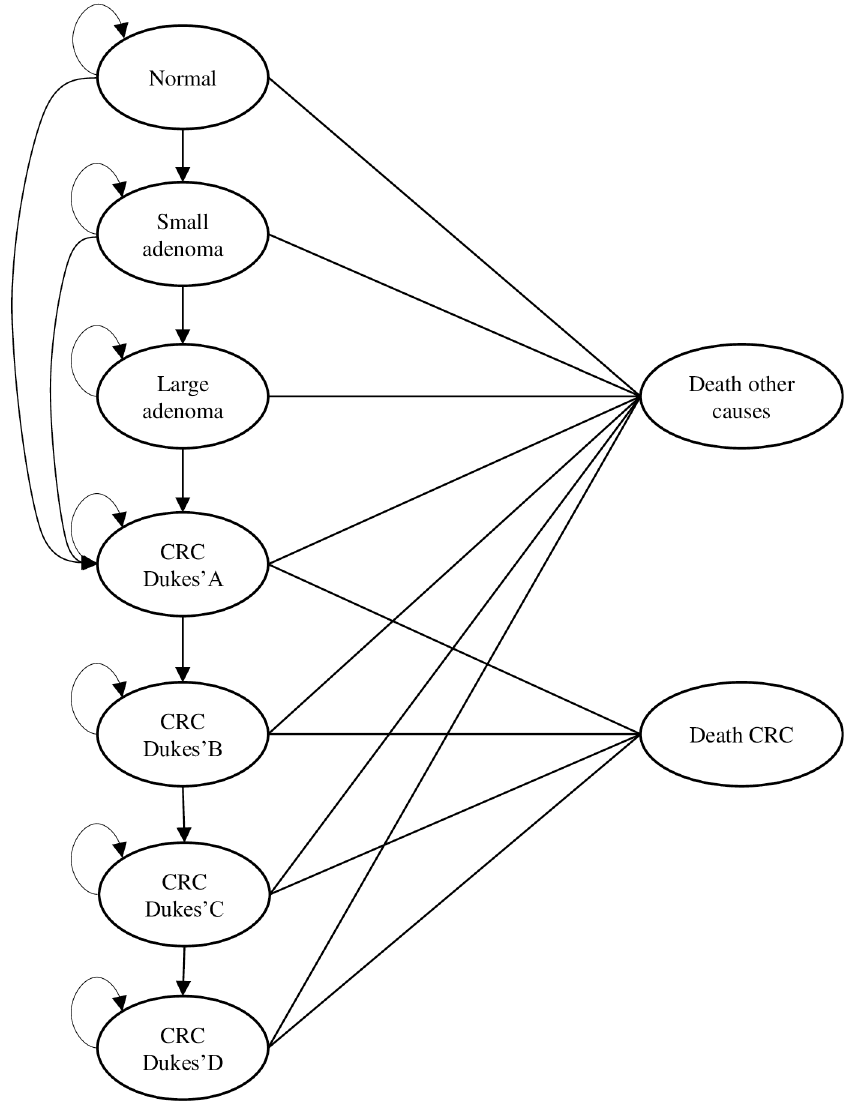
Fig 1. Structure of the microsimulation model. Note: all states (apart from death, which is absorbing) are transient, which enables individuals to move to other states by the predetermined state transition probabilities or remain in the same state. CRC, colorectal